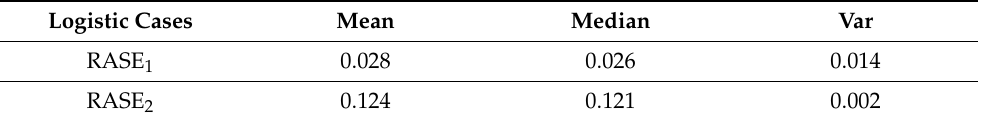
Table 16. The RASE criterion with the nonparametric function η ( . ) and slope function β ( . ) for the case where n =